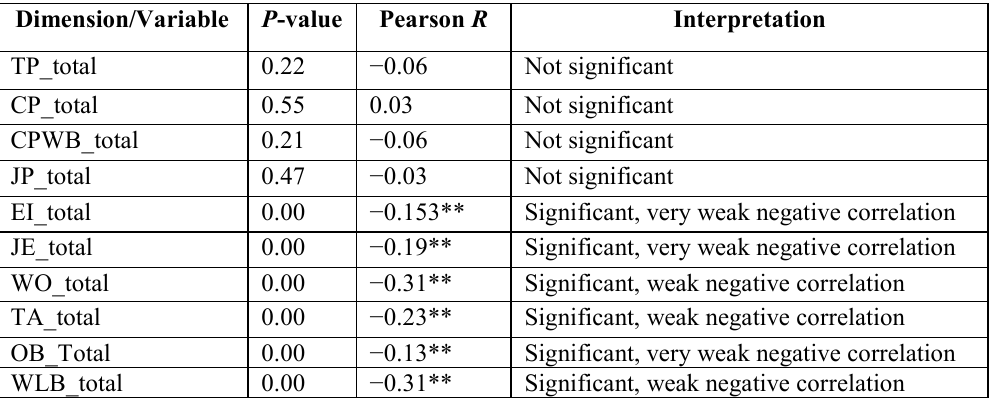
Table 1. Pearson R Correlation between Telecommuting Intensity and JP and WLB Dimension/Variable P -value Pearson R Interpretation TP_total 0.22 − 0.06 Not significant CP_total 0.55 0.03 Not significant CPWB_total 0.21 − 0.06 Not significant JP_total 0.47 − 0.03 Not significant EI_total 0.00 −0 .153** Significant, very weak negative correlation JE_total 0.00 −0 .19** Significant, very weak negative correlation WO_total 0.00 −0 .31** Significant, weak negative correlation TA_total 0.00 −0 .23** Significant, weak negative correlation OB_Total 0.00 −0 .13** Significant, very weak negative correlation WLB_total 0.00 −0 .31** Significant, weak negative